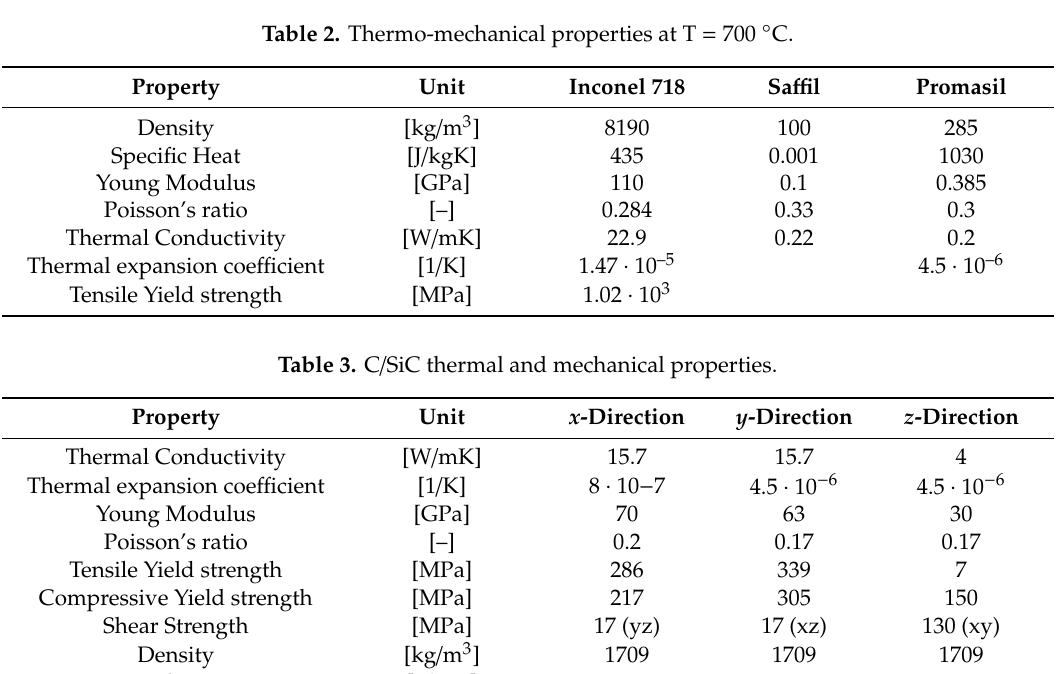
Table 2. Thermo-mechanical properties at T = 700 °C.